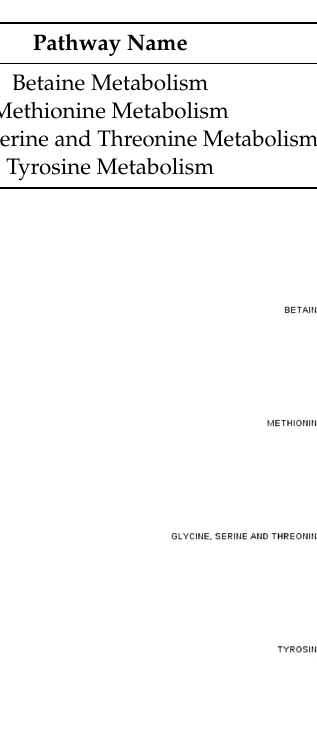
Table 2. Enrichment analysis of metabolites.